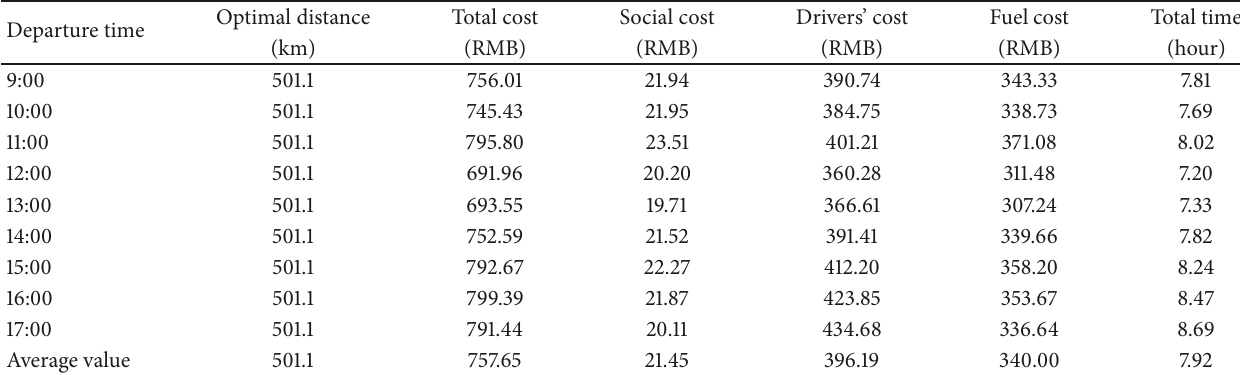
Table 3: Shortest-path solutions obtained by Floyd algorithms within various time